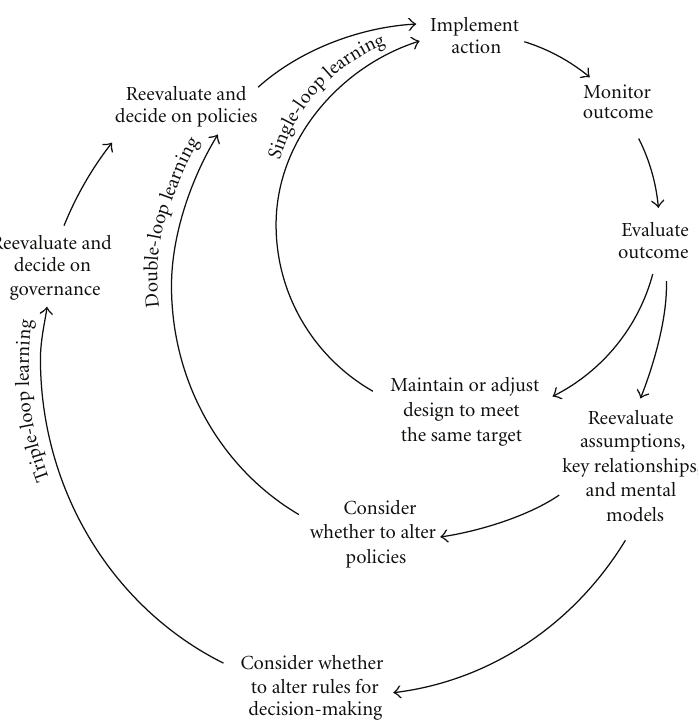
Figure 3: Di ff erent pathways and outcomes of institutional learning. Triple-loop learning involves the same re-evaluation of assumptions and models as double-loop learning but considers whether to alter rules for decision-making and fundamental changes in governance systems. Reprinted with permission from Folke et al. (2009:105)